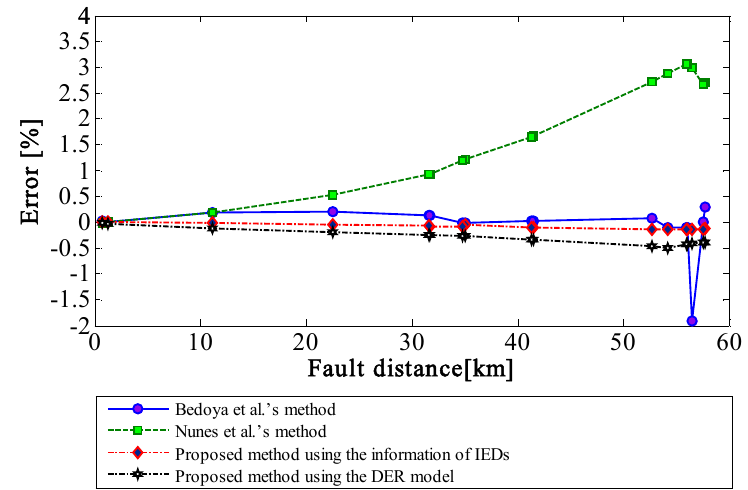
Figure 17. Performance curve for the proposed method and comparison with Nunes et al.’s [16,17] and Bedoya et al.’s [21] methods. Single-phase faults with resistance of 50 Ω .